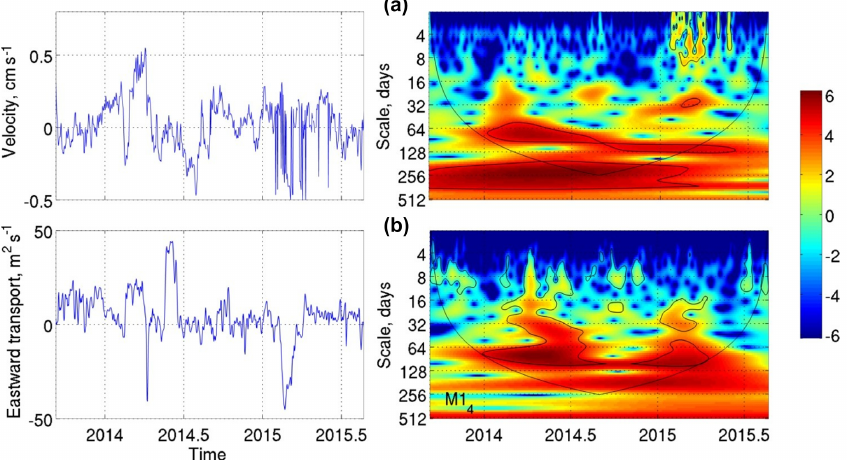
Figure 12. (a) Depth-averaged baroclinic velocities (cms − 1 ) in the AW layer (positive is eastward) between moorings M1 4 and M1 5 , estimated using geostrophic calculations, and their wavelet power. Before averaging, all baroclinic velocities profiles were shifted to satisfy a zero velocity condition at the surface. Time series and wavelet power (b) of depth-integrated transport in the AW layer at mooring M1 4 . All wavelet powers are in units of normalized variance. Black lines show significance at 95% confidence level